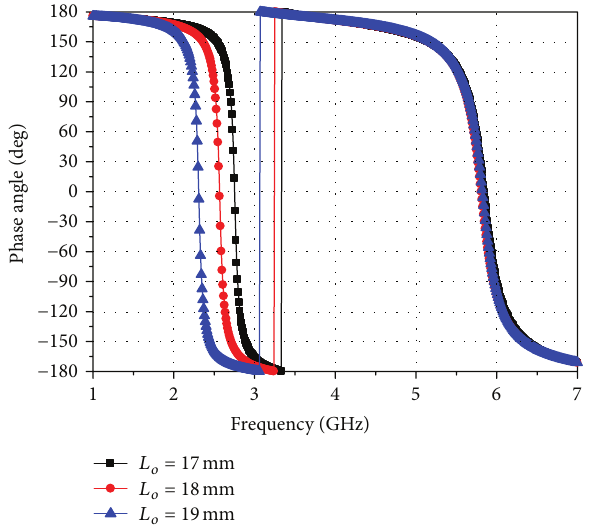
Figure 4: Effect of AMC parameter 𝐿 𝑜 .